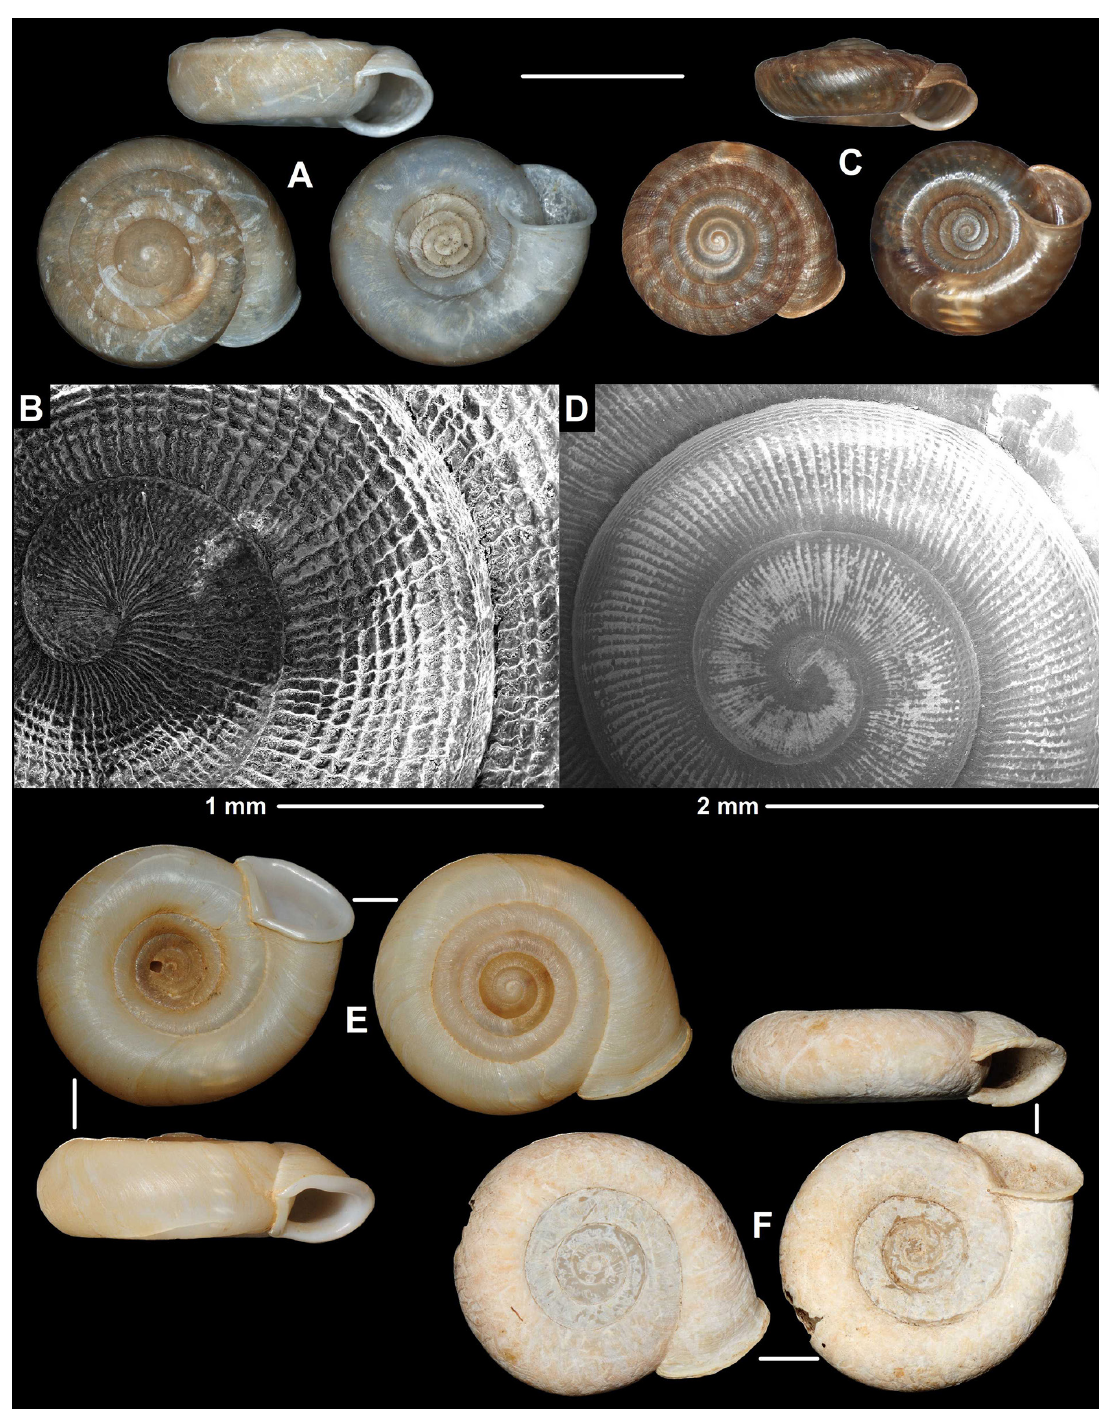
Fig. 31. Shells and protoconchs of species of Hunyadiscus Páll-Gergely, 2016 and Naggsia